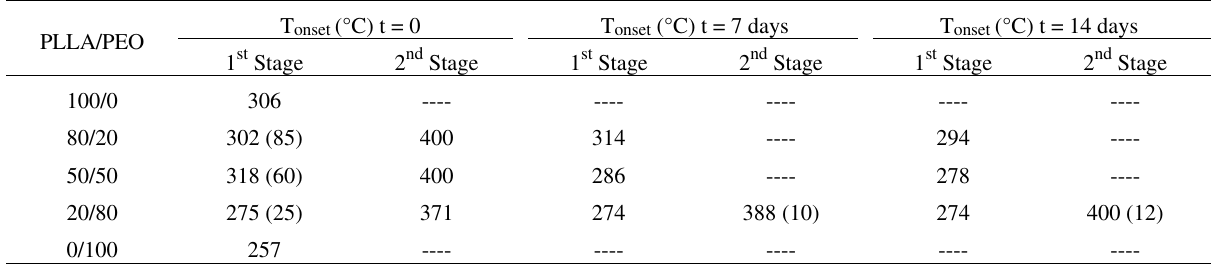
Table 2. T onset values for PLLA/PEO blends of different compositions as a function of the period of immersion in the buffer. In parenthesis, the mass loss percentage associated to the process, is given. PLLA/PEO